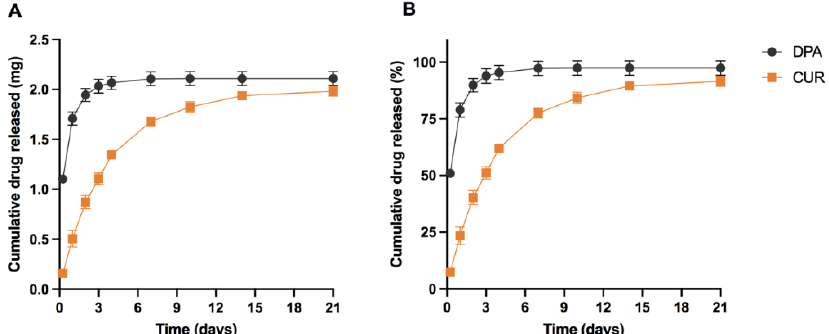
Figure 4. Release profiles of CUR and DPA in PBS (pH 7.4) with the addition of 0.5% w / v of Tween ® 80 and 0.1% w / v of ascorbic acid over 21 days. Cumulative drug released ( A ) in mg and ( B ) in percentage. Data points are expressed as means ± SEM., n = 3.